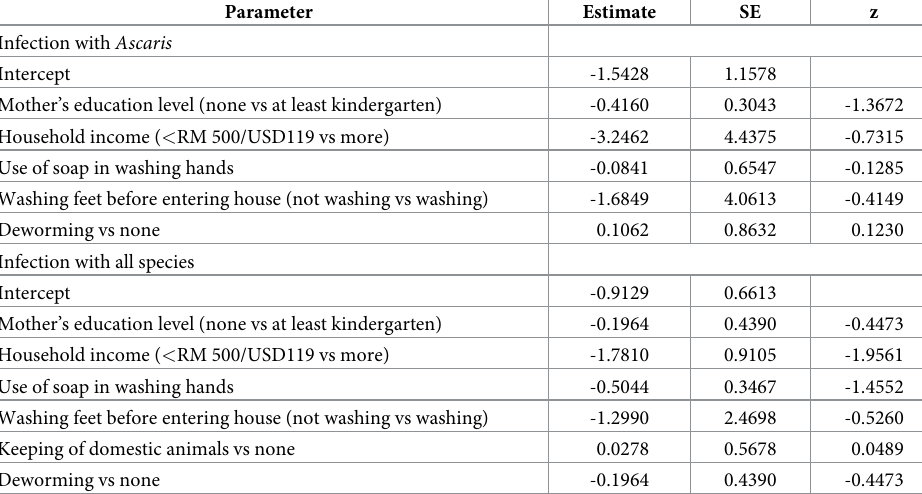
Table 8. Analysis using generalized linear model with villages considered as clusters of geohelminthiasis. Boot- strapping with 5000 replicates was performed. The parameter “proper sanitation” had been omitted since it has only one level in some